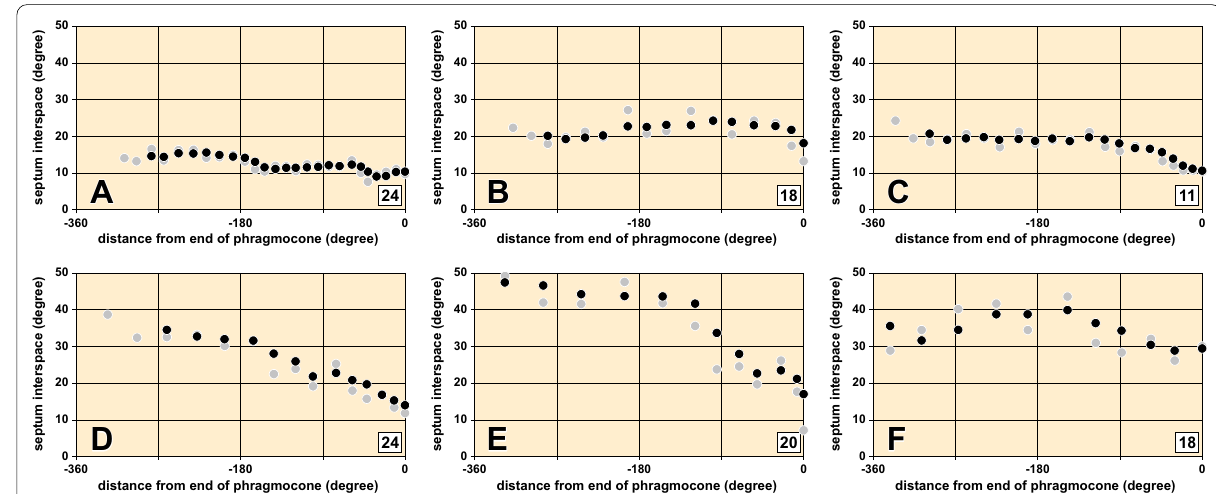
Fig. 4 Ontogenetic trajectories representative for the six distinguished groups with different modes of septal distance, shown in specimens of Late Tournaisian ammonoids from Oued Temertasset (Algeria). Phragmocone diameters in the lower right boxes. Grey dots data; black dots three neighbouring data points averaged. A Group 1: Jerania persimilis Korn, Bockwinkel & Ebbighausen, 2010a; specimen = MB.C.18940.1. B Group 2: Muensteroceras multitudum Korn, Bockwinkel & Ebbighausen, 2010a; specimen MB.C.18992.1. C Group 3: Helicocyclus inornatus Korn, Bockwinkel & Ebbighausen, 2010a; specimen MB.C.19035.1. D Group 4: Pericyclus intercisus Korn, Bockwinkel & Ebbighausen,